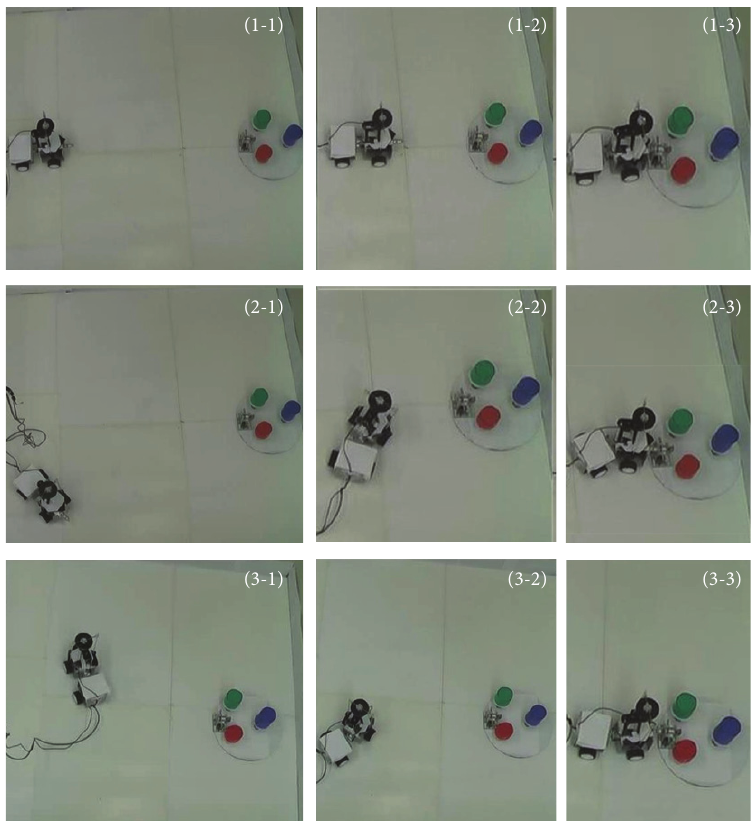
Figure 21: A set of experiments, performed to visualize the connection